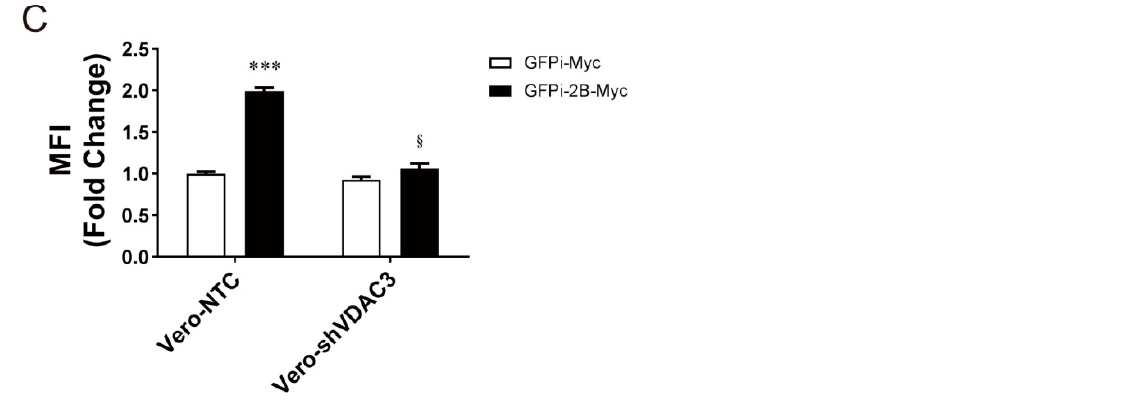
Figure 7. 2B interacts with VDAC3 to induce mitochondrial ROS generation. ( A ) Vero cells were transfected with the GFPi-2B-Myc or GFPi-Myc expression vector. Forty-eight hours later, the cells were stained with MitoSOX Red for quantification of mitochondrial ROS. The results are mean ± SD, n = 6. ** p < 0.01 vs. the GFPi-Myc-expressing cells. ( B ) Vero cells were transfected as described above, and treated without or with 100 µ M and 200 µ M Mito-TEMPO at 24 h after transfection. Twenty-four hours later, the cells were stained with MitoSOX Red for quantification of mitochondrial ROS. The results are mean ± SD, n = 6. * p < 0.05, ** p < 0.01 vs. corresponding untreated cells. ( C ) Vero-shVDAC3 and Vero-NTC cells were transfected with the GFPi-2B-Myc or GFPi-Myc expression vector. Forty-eight hours later, the cells were stained with MitoSOX Red for quantification of mitochondrial ROS. The results are mean ± SD, n = 6. *** p < 0.01 vs. Vero ‐ NTC cells; § p <0.05 vs. the GFPi ‐ 2B ‐ Myc ‐ expressing Vero ‐ NTC cells.